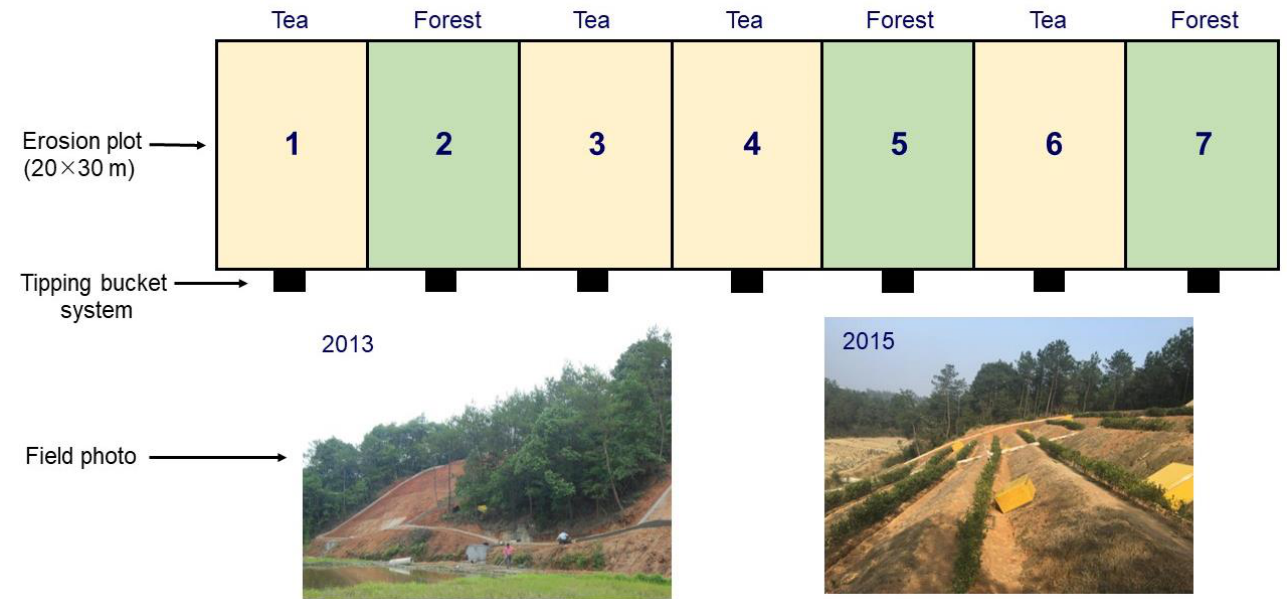
Figure 1. Sketch and photos of the experimental plot setup.